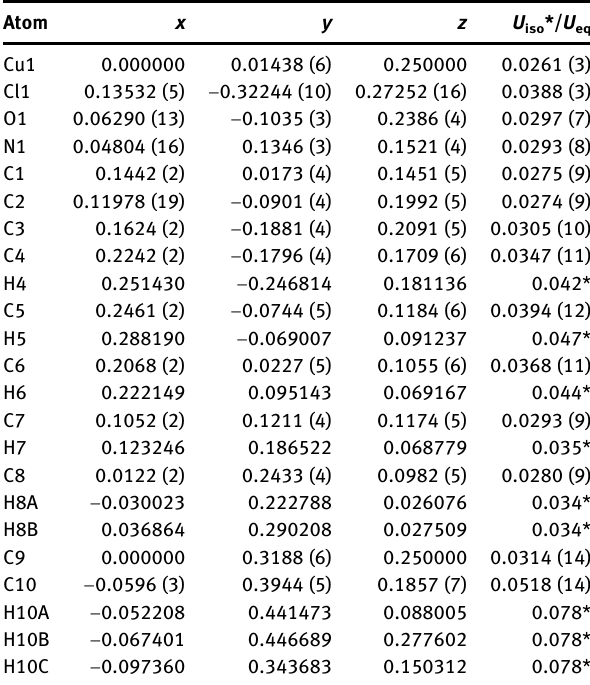
Table  : Fractional atomic coordinates and isotropic or equivalent isotropic displacement parameters (Å 